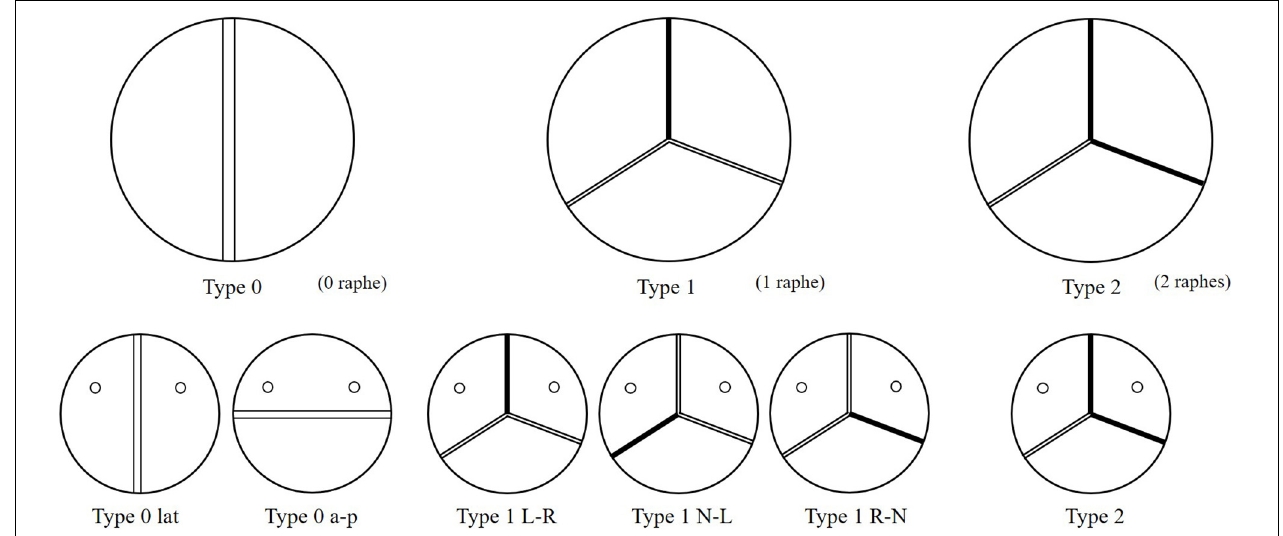
FIGURE 1 | Schematic of six phenotypes of BAV models.